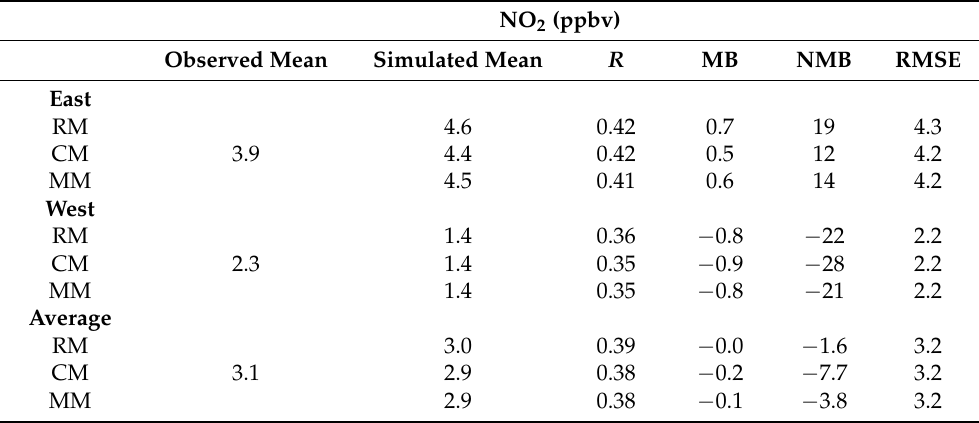
Table 5. Statistical analysis of predicted hourly NO 2 concentrations for the RACM-MADE/SORGAM (RM), CBMZ-MOSAIC (CM), and MOZART-MOSAIC (MM) chemistry-aerosol mechanisms. All stations considered have ≥ 90% of available hourly data.